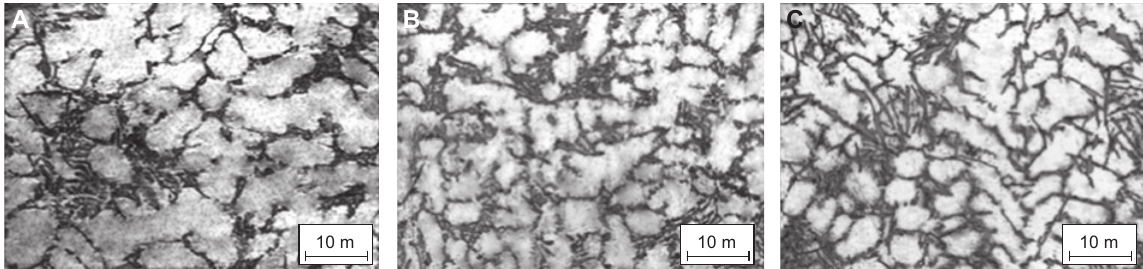
Figure 2 Microstructure of SiC-reinforced composite coating by GTAW. (A) Specimen with 15 wt. % of SiC and stirring velocity of 1 g . SiC particles are homogeneously distributed in the aluminum matrix. (B) Specimen with 20 wt. % of SiC and stirring velocity of 4 g . SiC particles are homogeneously distributed in the aluminum matrix. A further SiC content and desired distribution in the matrix could be shown. (C) Specimen with 20 wt. % of SiC and stirring velocity of 8 g . SiC particles are homogeneously distributed in the aluminum matrix. The porosity volume of the composite